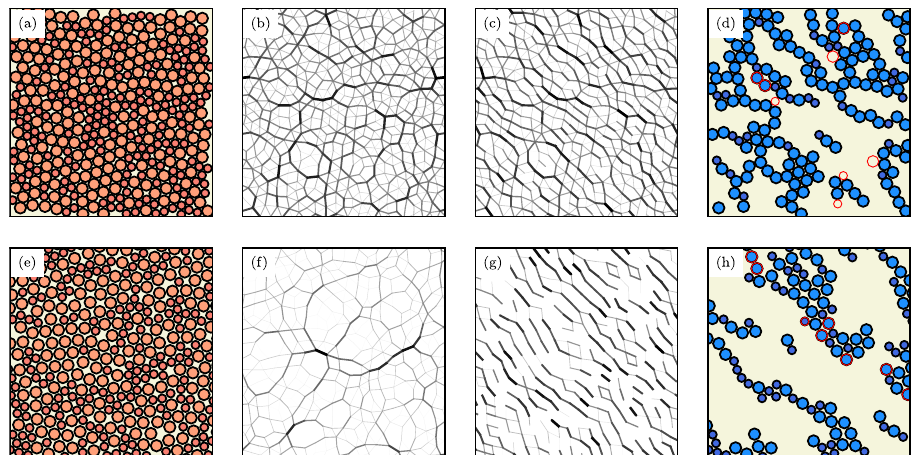
Fig. 4 Visualization of force network evolution under deformation and corresponding neural network prediction accuracy. a Example con fi guration before deformation with n A = n B = 200 particles interacting through a harmonic potential (as given in Eq. (1)) at packing fraction ϕ = 1.0. b Corresponding force network. c Force network after deformation with step strain of amplitude γ = 0.1. d Force chains of the con fi guration in ( c ). Differences between simulation and GNN prediction on the basis of ( a ) are highlighted in red. e – h Same as in ( a – d ) but now for a con fi guration at a packing fraction ( ϕ = 0.845) close to jamming.